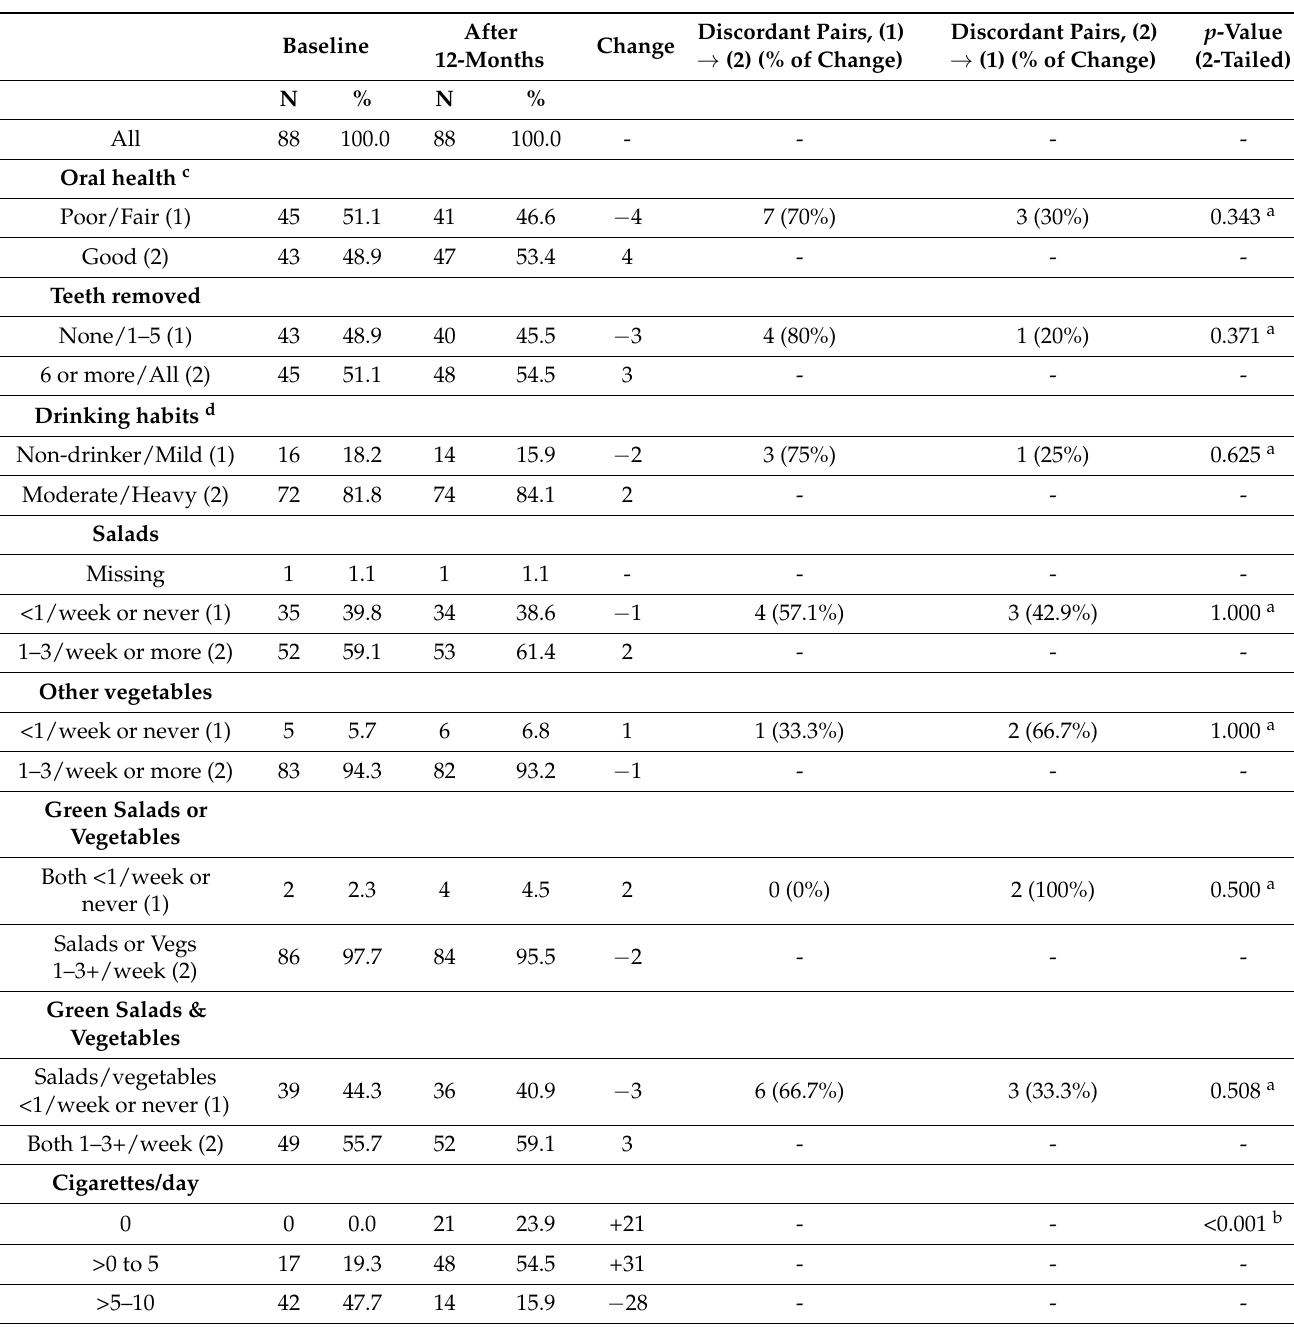
Table 1. Characteristics of subjects at baseline and at 12 months following a smoking cessation program.